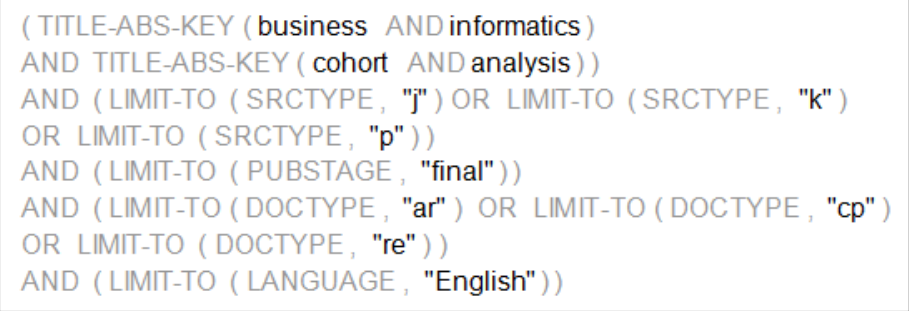
Figure 4. The search results by country and territory for the ( TITLE-ABS-KEY (business AND infor- matics) AND TITLE-ABS-KEY (cohort AND analysis)) query during the 2007–2020 period. The data in Table 2 show that organizations of only few countries explore cohort analysis usage in business informatics, and the numbers are drastically low. They have mostly the same number of papers published year by year. We should highlight that these countries (e.g., the United States, Germany, and the United Kingdom) are the leading ones in their regions at economic growth and development. So, building further research on cohort analysis in business informatics in other countries can lead to establishing best practices and new developments in these areas specific to particular country industries.